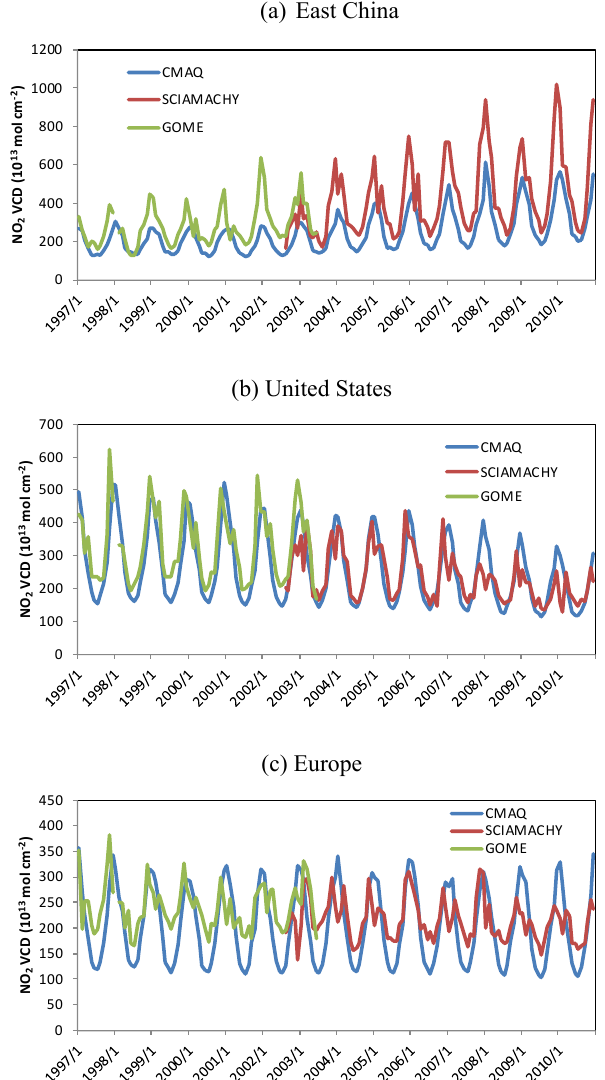
Figure 14. Comparison of changes in regional- and monthly- average modeled NO 2 vertical column density with satellite re- trievals from SCIAMACHY and GOME for (a) East Asia, (b) the United States, and (c)